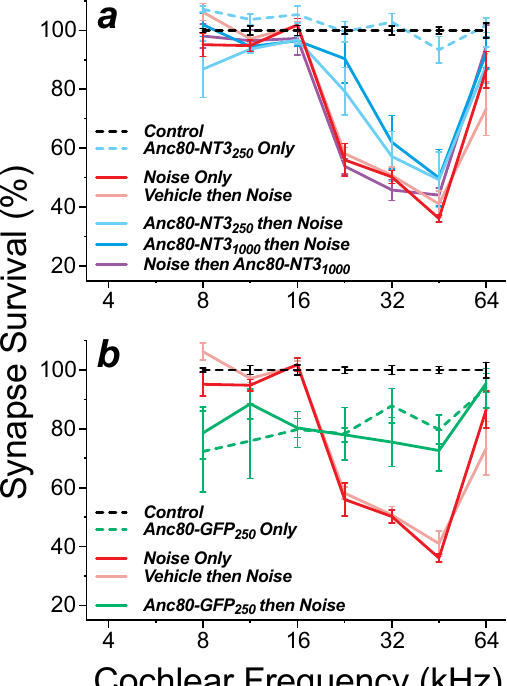
Figure 4. NT3 overexpression reduced noise-induced synaptopathy ( a ), while GFP overexpression increased synaptopathy with or without noise ( b ). ( a ) Summary of synaptic survival for AAV-NT3 groups and relevant controls. Group sizes were as follows: Controls (n = 4), Noise Only (n = 7), Vehicle then Noise (n = 4), Anc80-NT3 250 Only (n = 4), Anc80-NT3 250 then Noise (n = 7), Anc80-NT3 1000 then Noise (n = 7) and Noise then Anc80-NT3 1000 (n = 5). ( b ) Summary of synapse survival for AAV-GFP groups and relevant controls. Control , Noise Only and Vehicle then Noise groups are the same as in Panel a. Group sizes for the GFP groups were as follows: Anc80-GFP 250 Only (n = 4), and Anc80-GFP 250 then Noise (n = 5). Means ( ± SEMs) are shown in all plots. All data are normalized to mean values in unexposed